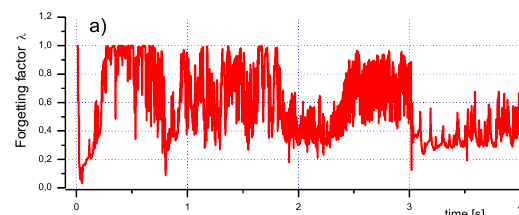
Fig. 5. Change of exponential forgetting factors  t 4 Experimental test stand In the algorithms research of control electro-hydraulic servo drive is used the test stand. In the Fig. 6 presented a view of the test stand consisting of the electro-hydraulic servomechanism controlled by the proportional flow valve (2). The force is achieved by weights installed on the linear guide support (5). Servomechanism control systems is using the card of C/A converters. Displacement of the linear guide block is measured relatively to the corps test stand with the converter position Novotechnik Company (4). Velocity of the linear guide block is calculated by the differentiation piston position of the actuator (1). In the system there is also possible measurement of the technological resistance force using the force sensor (3). Hydraulic power supply is also included in the test stand ( P max = 31.5 MPa), along with the proportioned pressure valve (DBETR-10/315G24K4M-381). The test stand also includes computer system in the superior control system equipped with the Matlab/Simulink (xPC Target) software. The microcomputer has cards of converters C/A and A/C of the PCI type – DAS1602/16 Measurement Computing Corporation. Card along with the converter of position and force creates the measurement system [9].